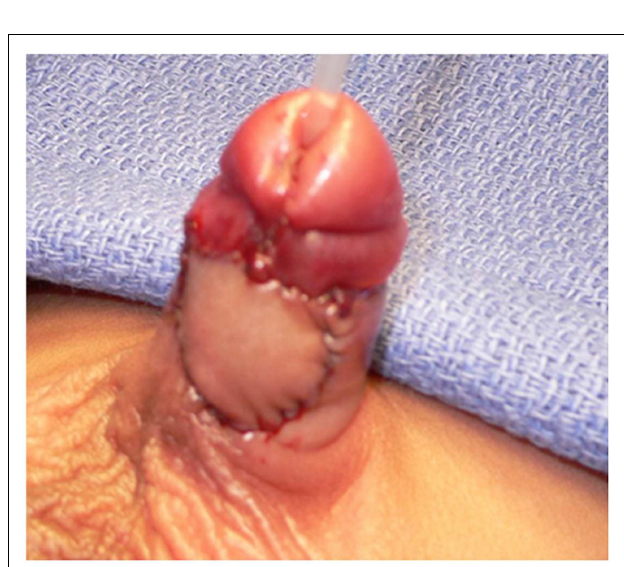
FIGURE 4 |TPF used for ventral coverage only in patient with severe chordee. The urethroplasty was done with a meatal based flap.